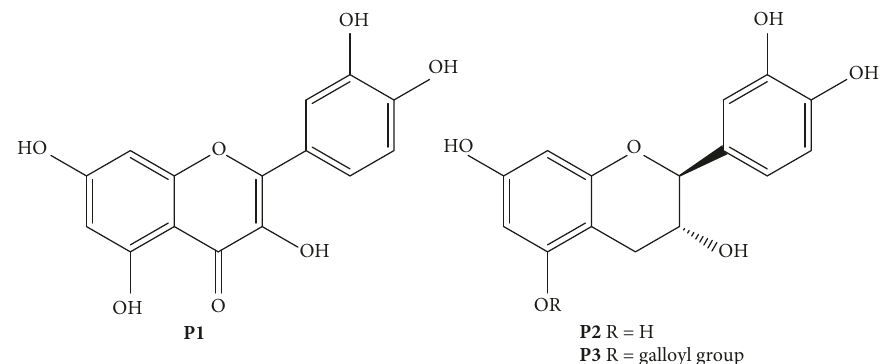
Figure 1: Structure of compounds P1 , P2 , and P3